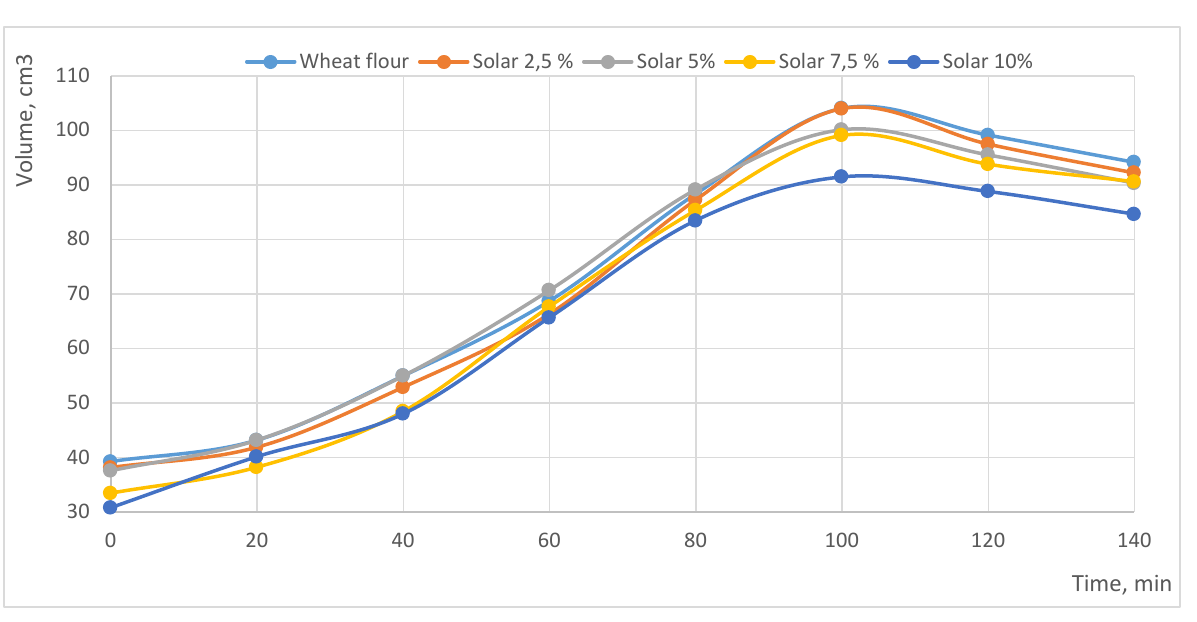
Figure 4a. The impact of the addition of Jerusalem artichoke flour on the volume of the dough during fermentation: dough from wheat flour (control sample,) dough from wheat flour- Jerusalem artichoke Solar variety in concentration of 2,5 %, 5%, 7,5% and 10%.